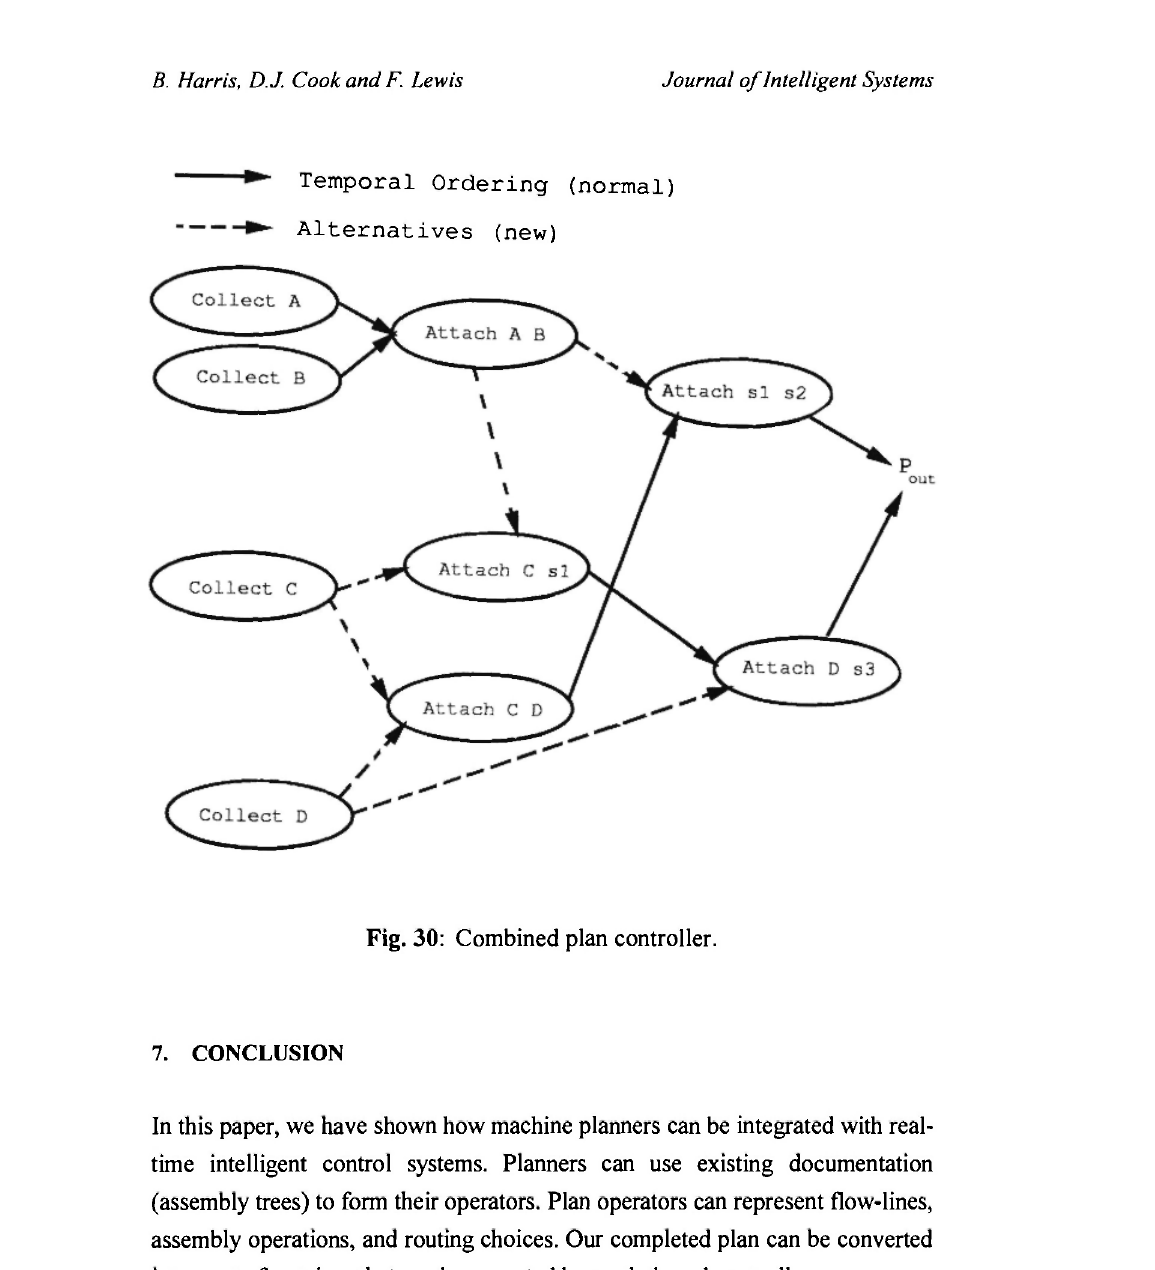
Fig. 30: Combined plan